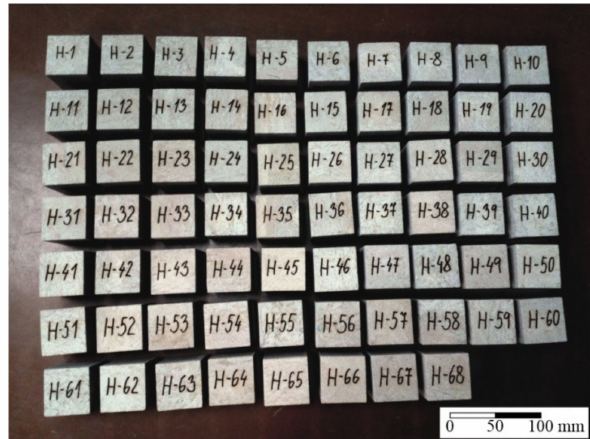
Figure 1. Cubic samples of